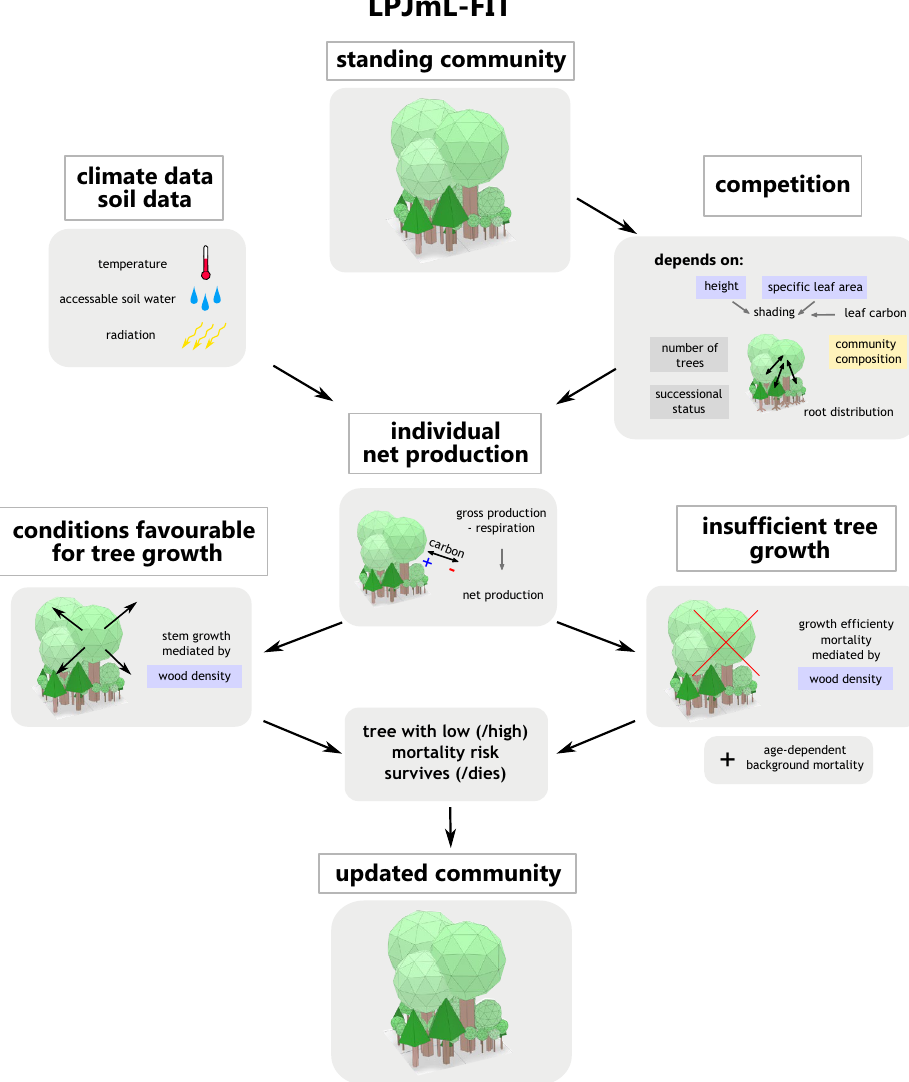
Figure 6. Scheme of central mechanisms of the LPJmL-FIT modelling approach. Local competition, climate input, and individual functional traits determine the net production of every tree individual. Tree survival depends on tree age and the individual carbon balance mediated by wood density. A more detailed description is found in Supplementary Methods